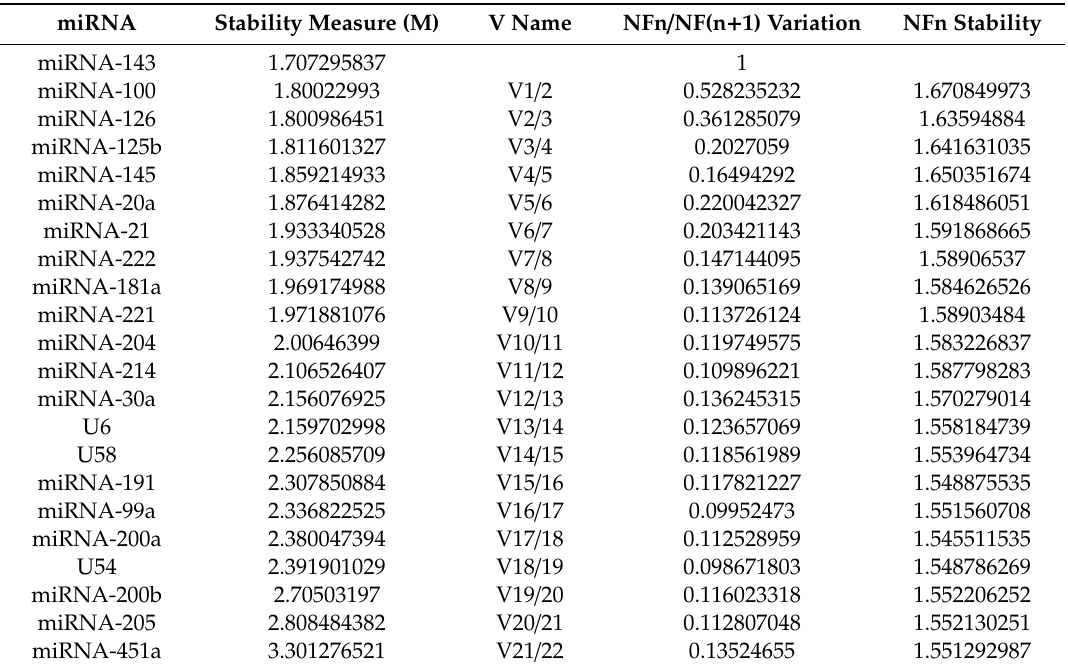
Table 1. Assessing gene stability with geNorm to determine the optimum number of reference genes. miRNA Stability Measure (M) V Name NFn / NF(n + 1)